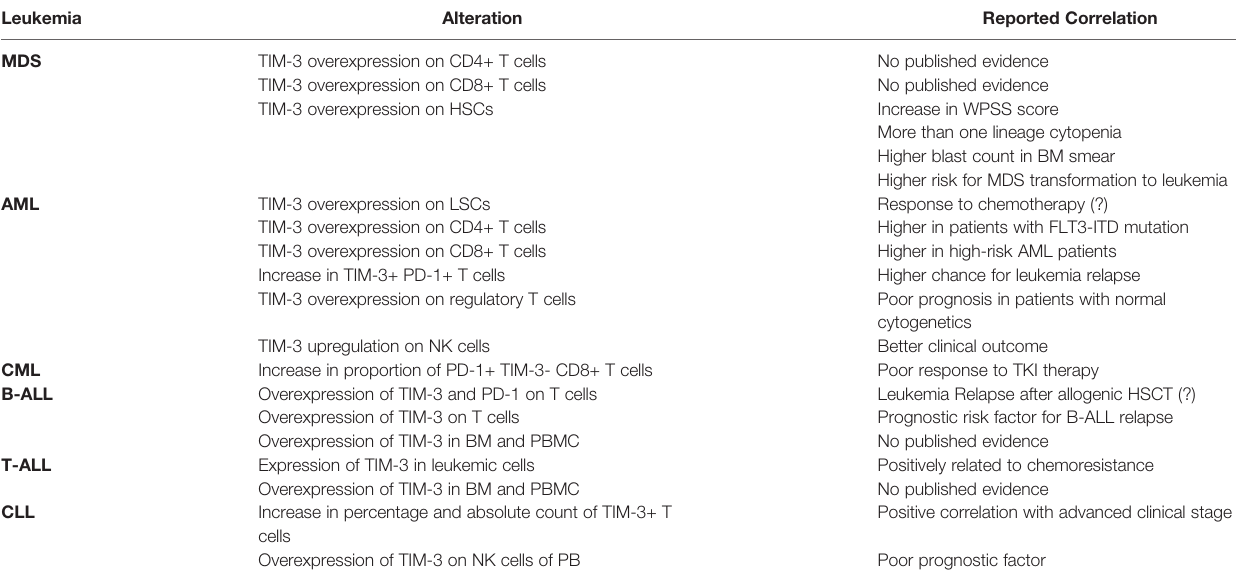
TABLE 1 | TIM-3 alteration in leukemias and reported correlations. Leukemia